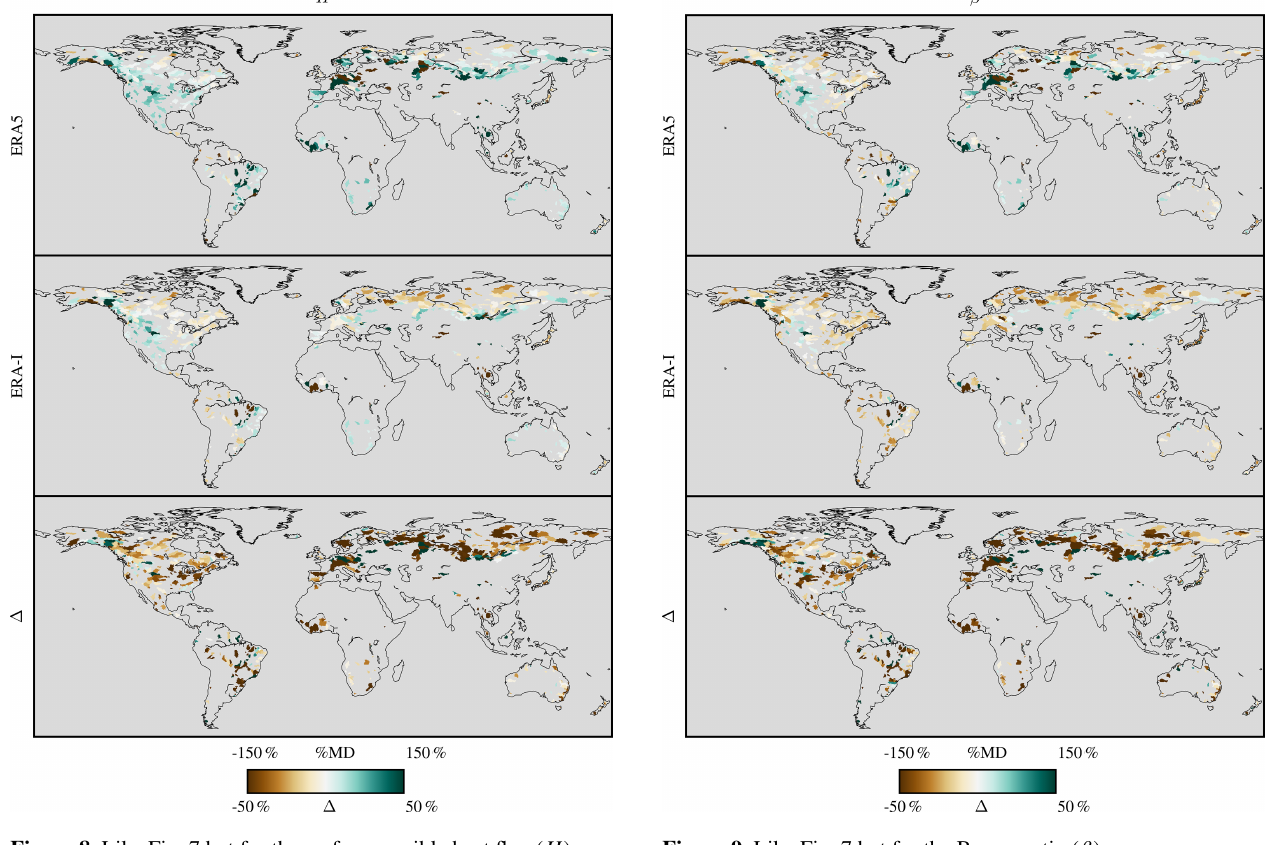
Figure 8. Like Fig. 7 but for the surface sensible heat flux ( H ). Figure 9. Like Fig. 7 but for the Bowen ratio ( β